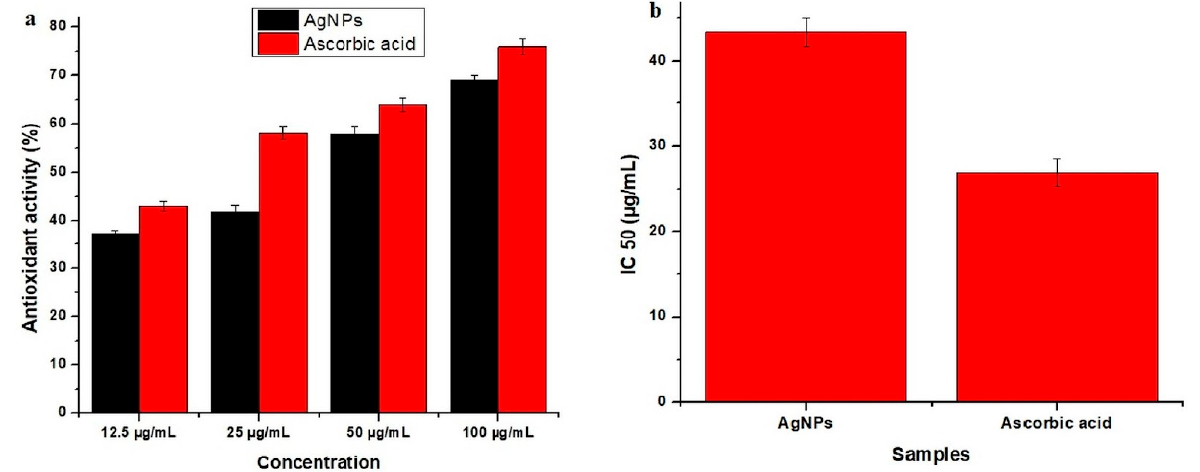
Figure 8. DPPH scavenging activity of AgNPs, ( a )% antioxidant activity at different concentrations, ( b ) IC 50 value at different concentrations.